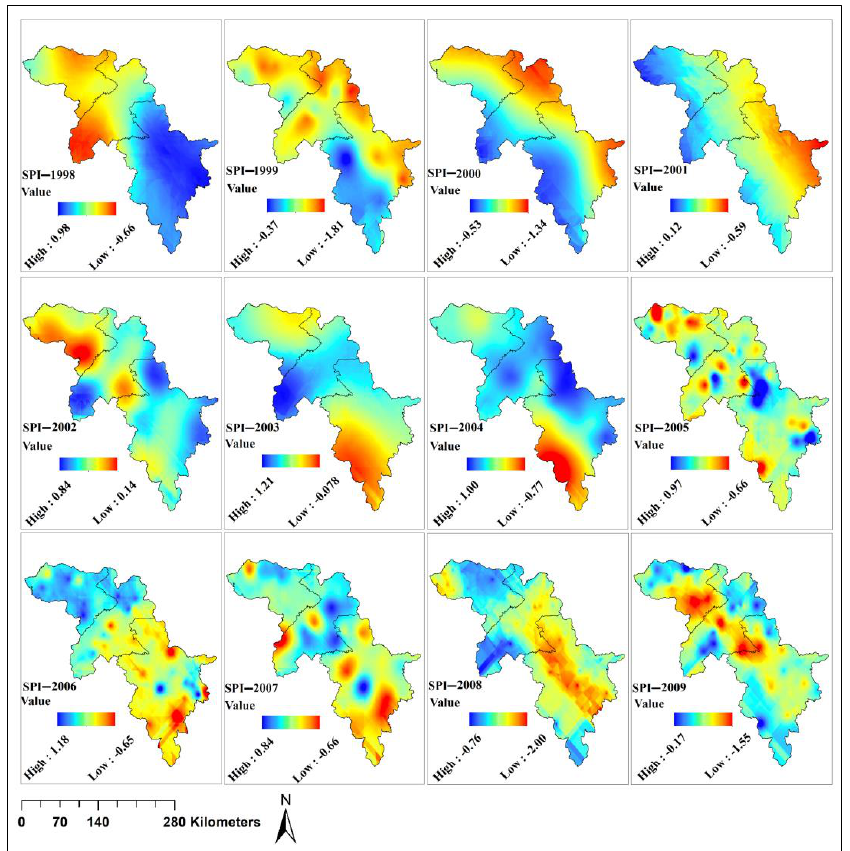
Figure 8. Temporal pattern of SPI drought and wet periods for 60 meteorological stations from 1998 to 2009.